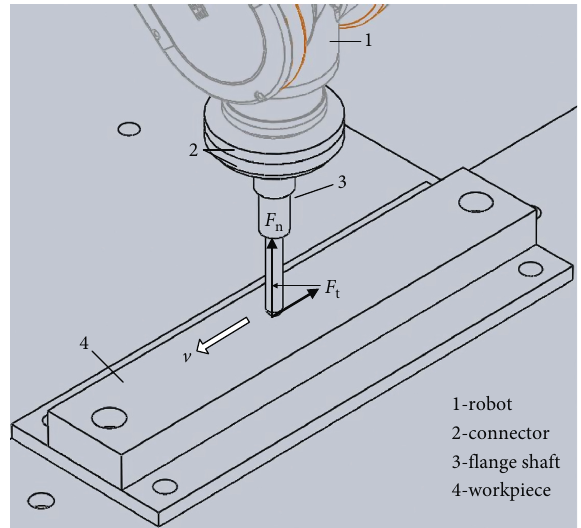
Figure 2: Schematic diagram of the contact between the robot end and the